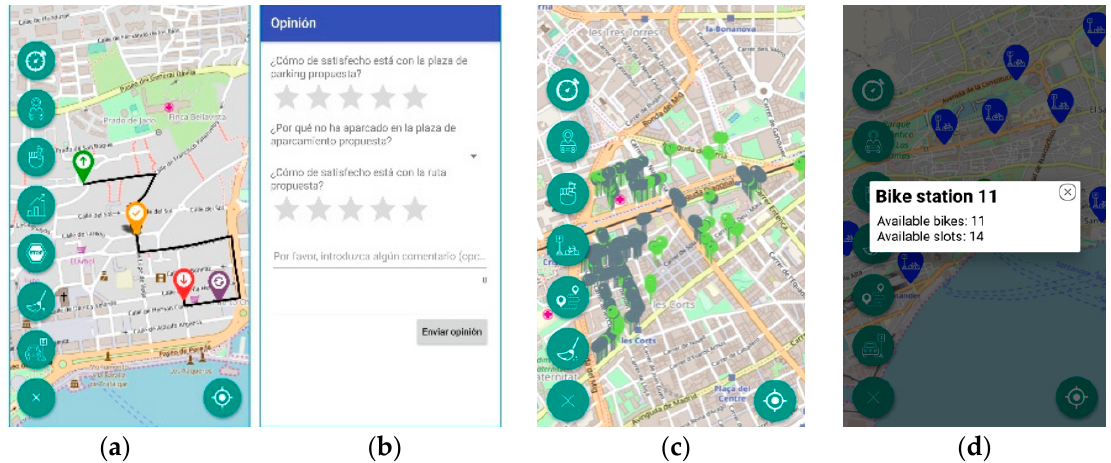
Figure 12. BigCitiesSmartMobility App mobile application features. ( a ) guidance to nearest available parking place; ( b ) experience feedback collection; ( c ) available and occupied parking spaces; ( d ) location of bike stations and availability of public bikes.